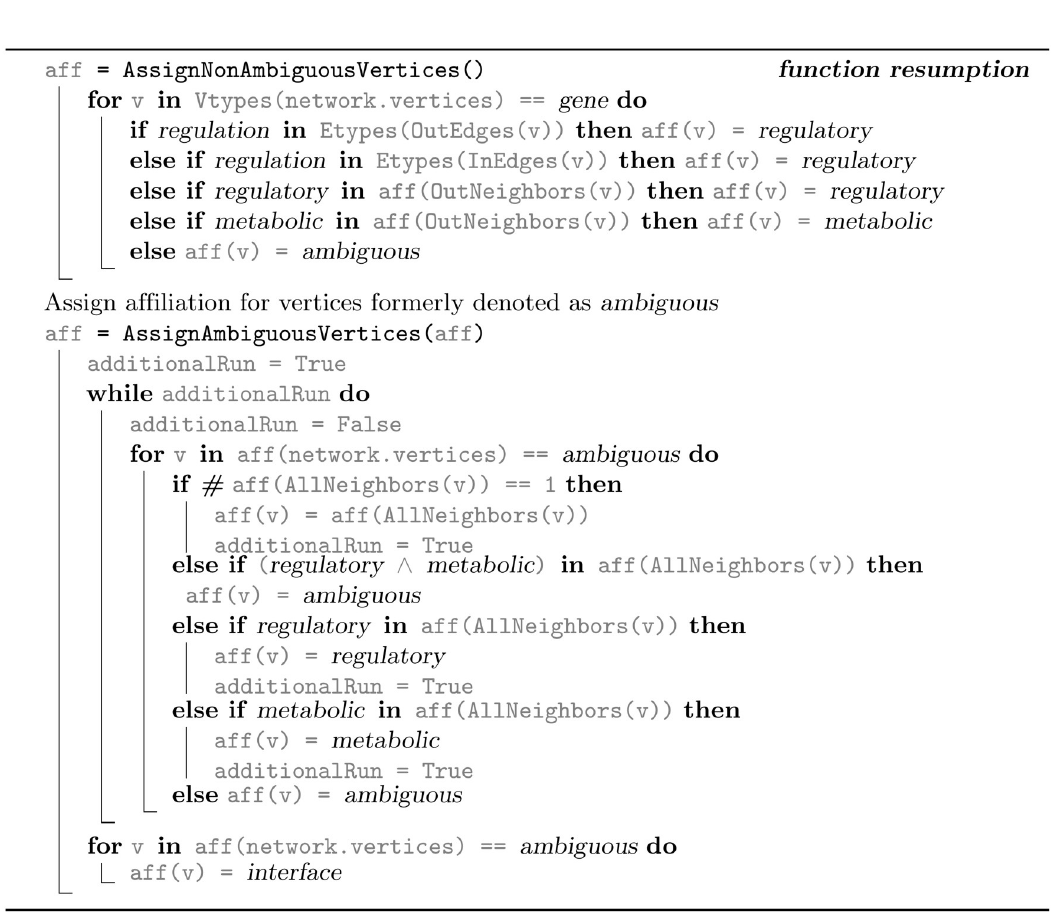
Fig 11. Algorithm 2B. Network affiliation compilation based on vertex type, and the vertex neighbors types and affiliations. Affiliation assignment for non-ambiguous genes and vertices assigned as ambiguous .